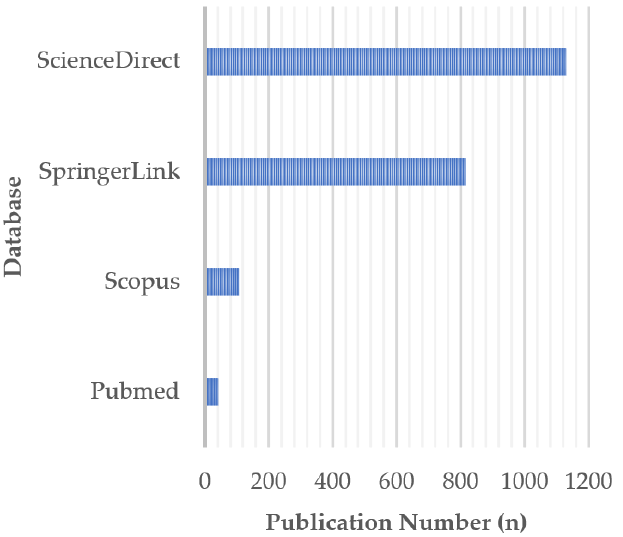
Figure 1. Publications in different databases between 2012 – September 2022 ( n = 2094).